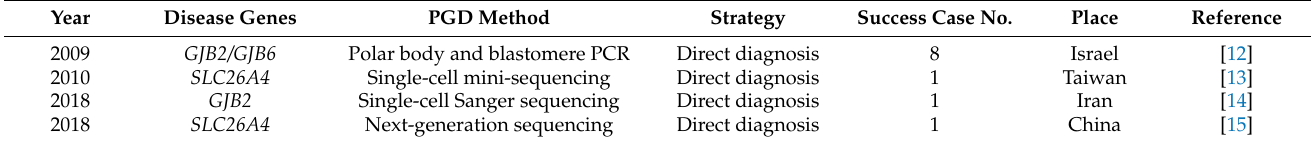
Table 2. Previous reports applying PGD to hereditary hearing